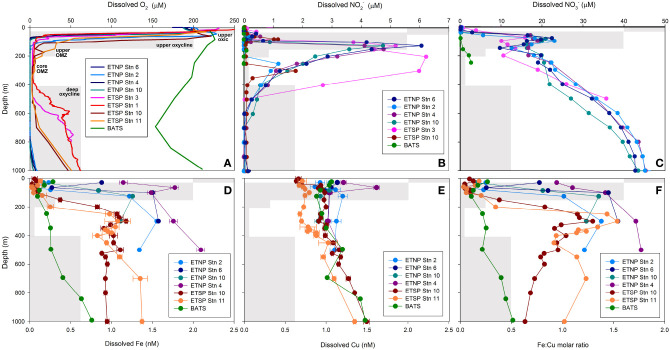
Depth profiles of dissolved (A) O2, (B) NO2−, (C) NO3−, (D) Fe, (E) Cu and (F) Fe:Cu molar ratios for stations 2, 4, 6 and 10 in the ETNP, stations 1 (BIG RAPA) and 3 (MOOMZ), 10 and 11 in the ETSP, and BATS in the Sargasso Sea, North Atlantic Ocean (see Supplementary Figure 1 for station maps). Gray boxes depict oxygen and depth ranges for each zone and their labels are shown in (A).